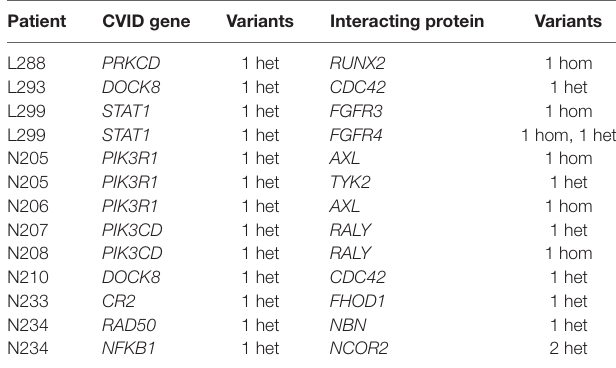
TaBle 5 | Number of genes harboring compound heterozygotes mutations in the patients included in this study. sample genes genes 1%